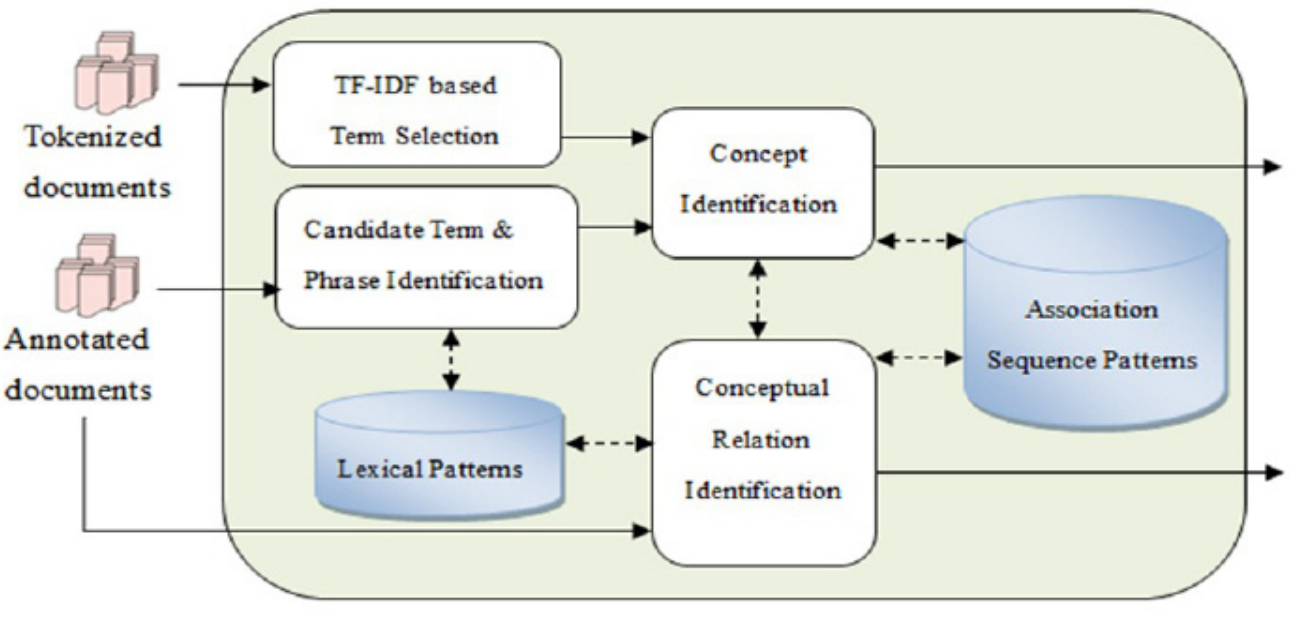
Figure 2. Learning